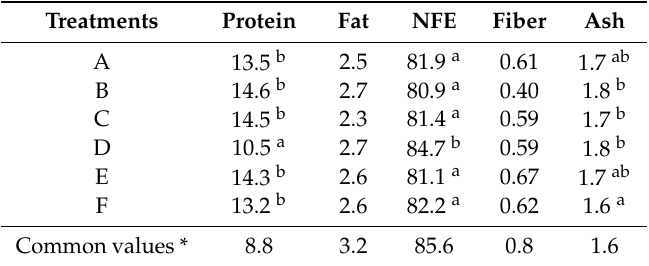
Table 5. Grain quality (%) of brown